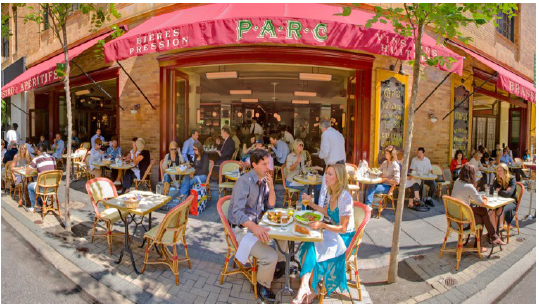
Figure 5. Sidewalk occupation by a restaurant patio